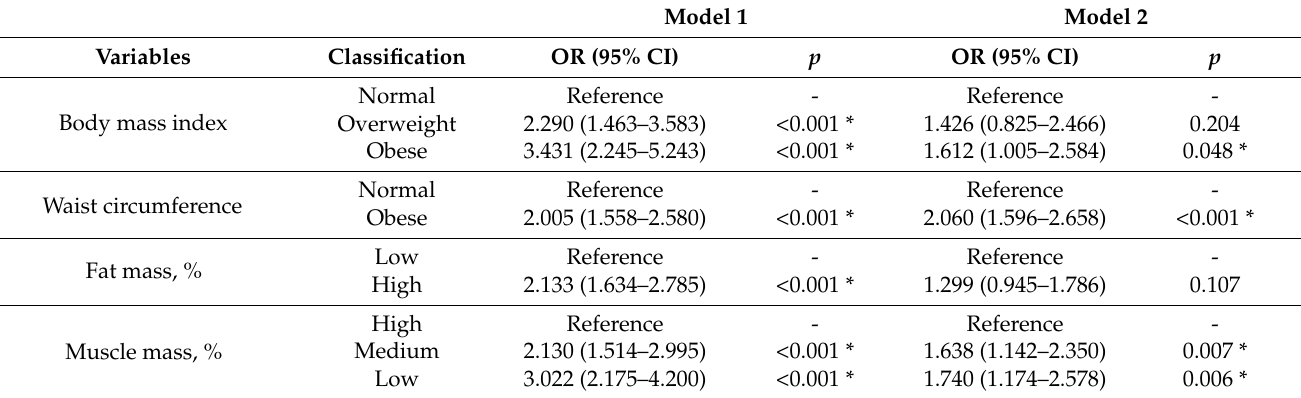
Table 3. Low testosterone prevalence according to BMI, waist circumference and body composition.